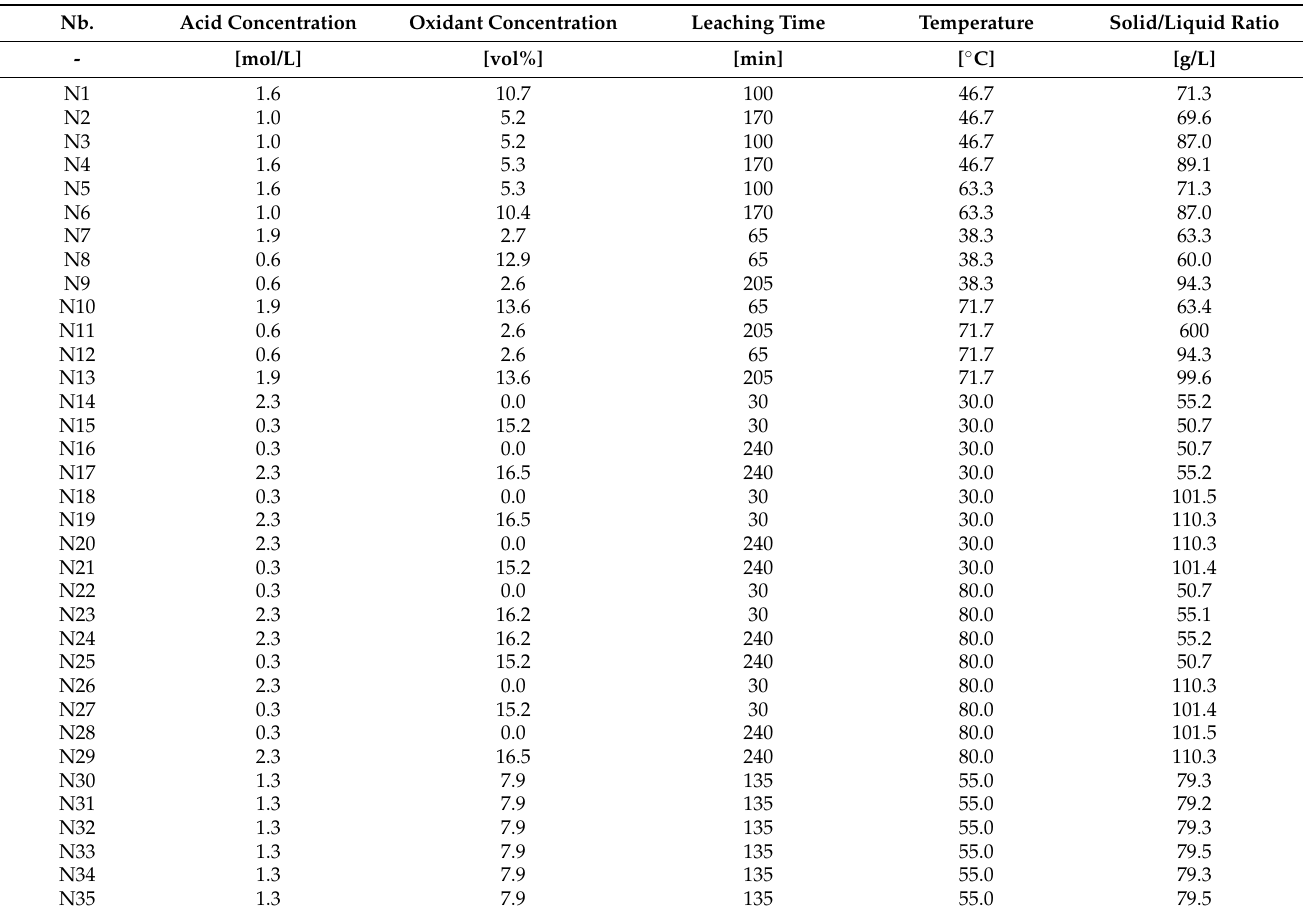
Table 4. Statistical experimental design for the investigations of the leaching behavior of LFP cathode